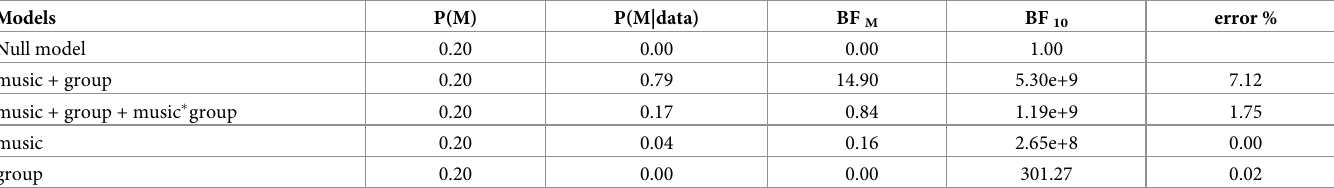
Table 8. Comparison of Bayes models: Music & group.